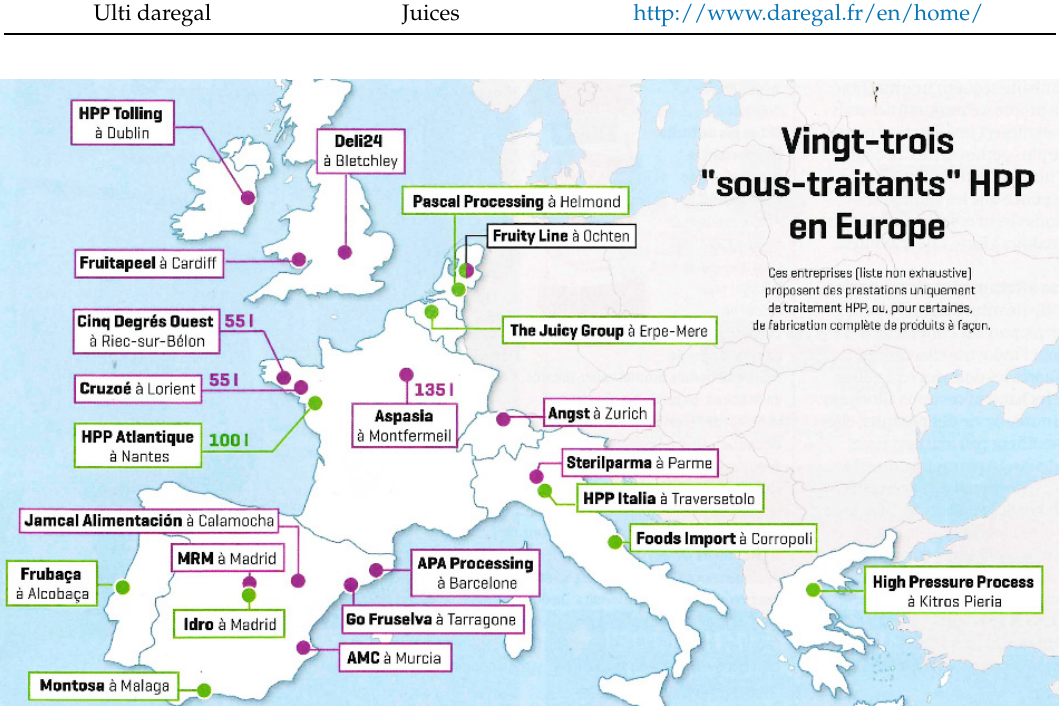
Figure 2. Placement of factories related to fruit/vegetable based beverages and other preparations in the EU [23].